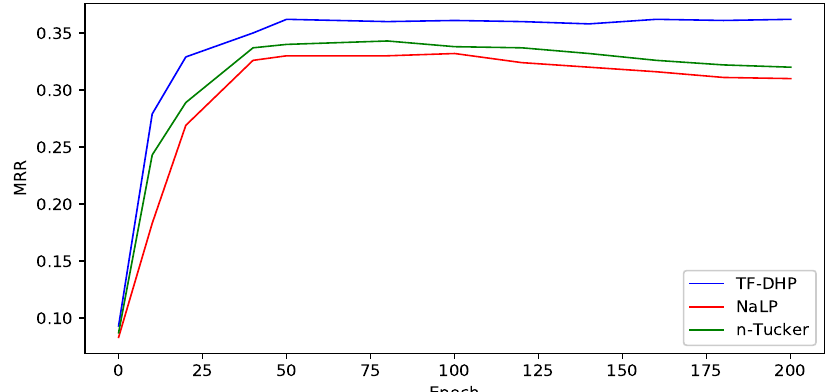
Figure 6. MRR under different training epochs of undirected hyperlink prediction models. Evaluated on